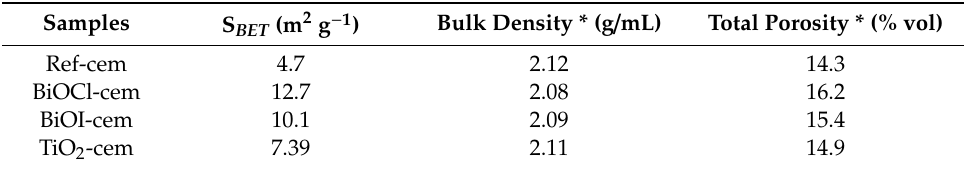
Table 3. Brunauer–Emmett–Teller (BET) and mercury intrusion porosimetry (MIP) results of mortar tested